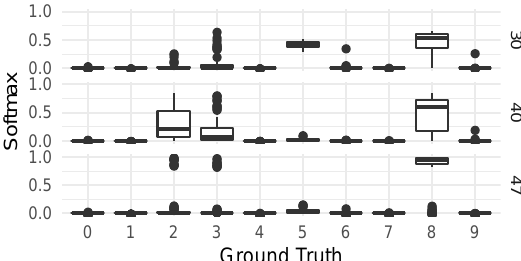
Figure 7. The failure modes for a ground truth of five. We see the distributions of predictions for the three failure modes: only group 30 attaches any significant likelihood to the digit 5 at all, while all three favor eight. For group 40, the digits two and three are also commonly suggested; this happens somewhat more rarely in groups 30 and